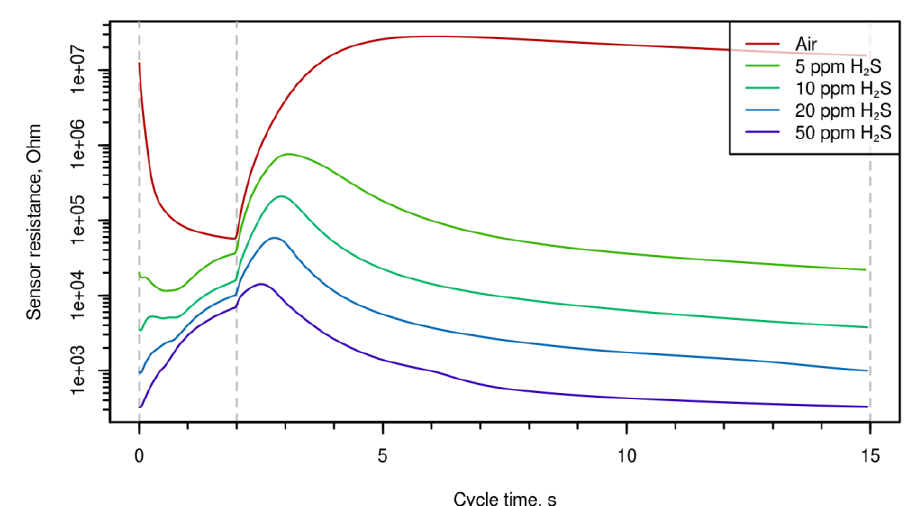
Figure 3. Time-resistance dependence for different hydrogen sulphide concentrations during one measurement period.